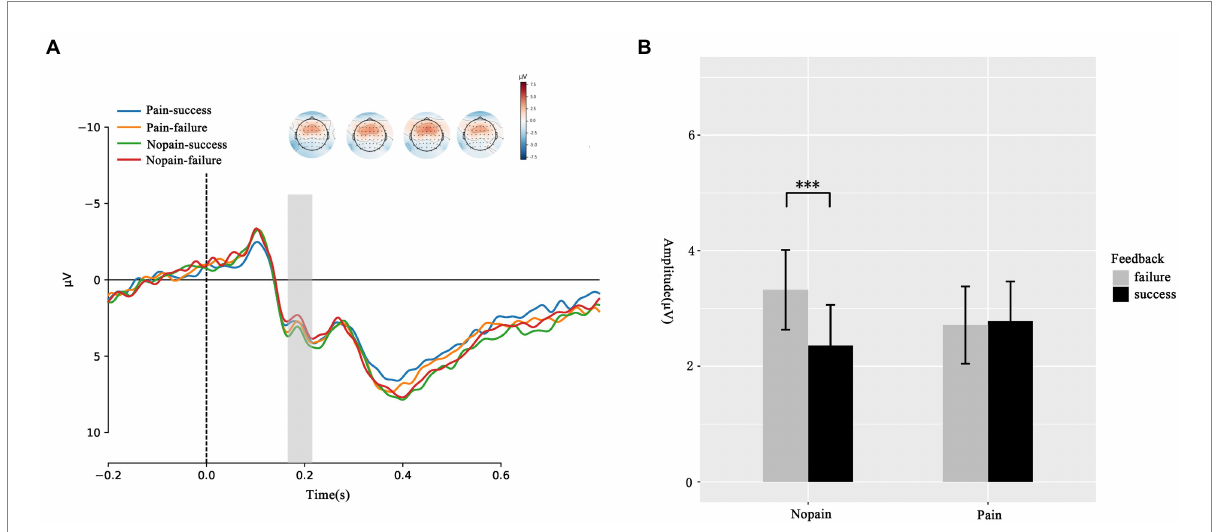
FIGURE 2 FRN responses during the feedback screen. (A) Average ERP waveforms and scalp topographies for pain (pain vs. nopain) and feedback (success vs. failure) during the task. Displayed waveforms were measured at FCZ. Amplitudes of dominant component FRN elicited by the feedback were compared. (B) Histogram for the FRN in the four conditions. *** p <